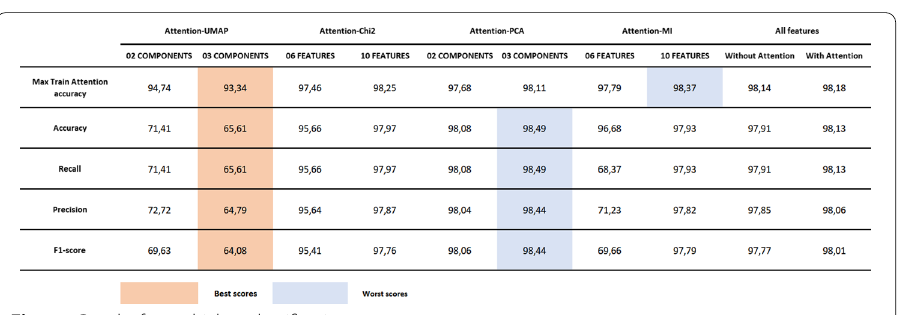
Fig. 14 Results for multiclass